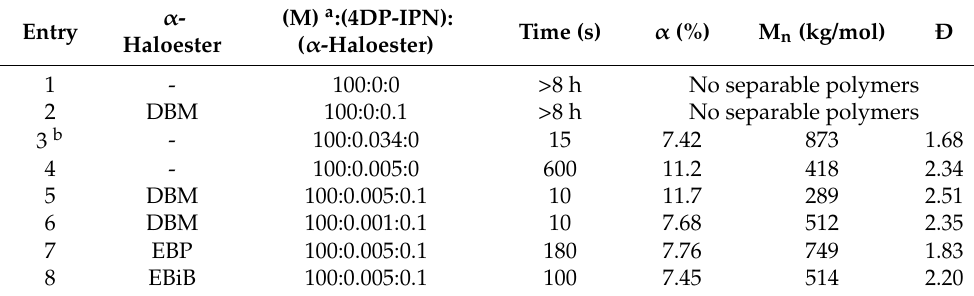
Table 1. Bulk polymerization results; α = gravimetrically determined conversion of bulk polymeriza- tion. Here, M denotes the monomer mixture, M n and Ð denote the number of the average molecular weight and dispersity, respectively, which were determined using size-exclusion chromatography, and DBM, EBP, EBiB, and 4DP-IPN denote diethyl 2-bromo-2-methylmalonate, ethyl 2-bromopropionate, ethyl α -bromoisobutyrate, and 2,4,5,6-tetrakis(diphenylamino)-1,3-benzenedicarbonitrile,